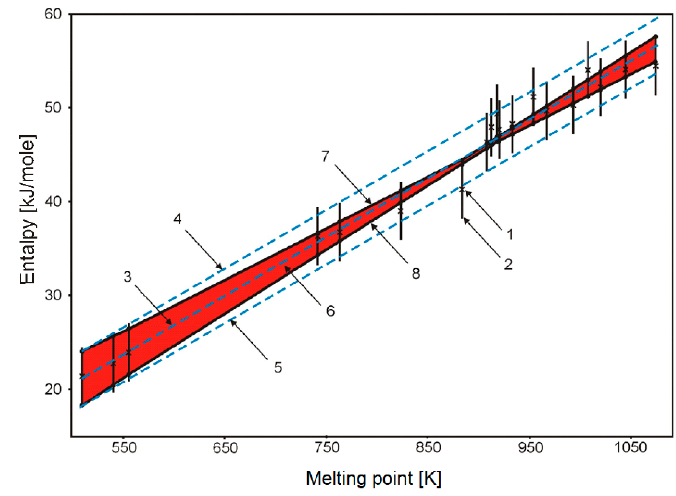
Figure 5. Results of estimation of admissible values of parameters for the approximation function H ( T ) = A * T + B . (1) Information set; (2) LSQM—estimate A LSQ , B LSQ ; (3) central point A cnt and B cnt of the information set. Grey area is an area of possibleA and B coefficientsts according interval analysis, red circle is a point of fiiting coefficients related to to LSQM